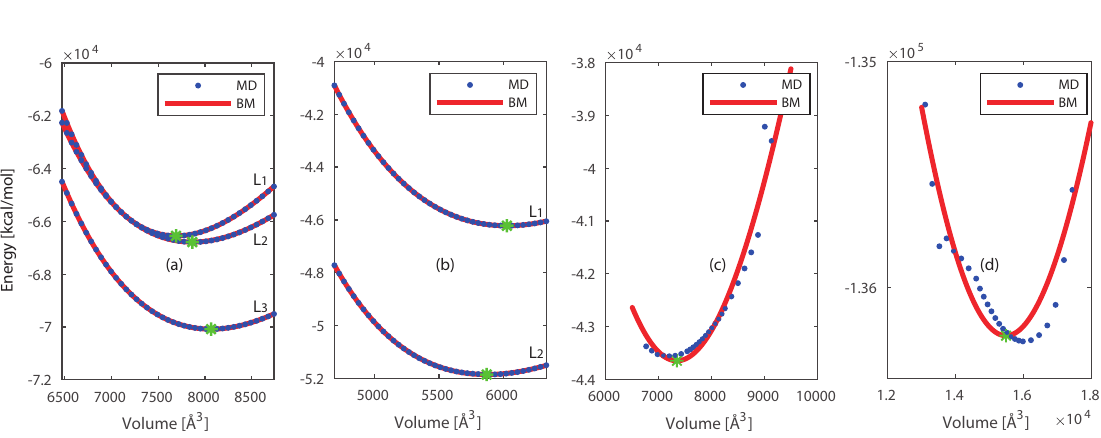
Figure 2. The energy of system obtained from selected force fields as a function of volume and the fitted BM-eos for: ( a ) 5 × 5 × 5 Pt, ( b ) 5 × 5 × 5 Ni, ( c ) 3 × 3 × 3 Si, and ( d ) 4 × 4 × 4 SiO 2 . The ‘ (cid:63) ’ represents the minimum energy point ( E 0 , V 0 ) on each